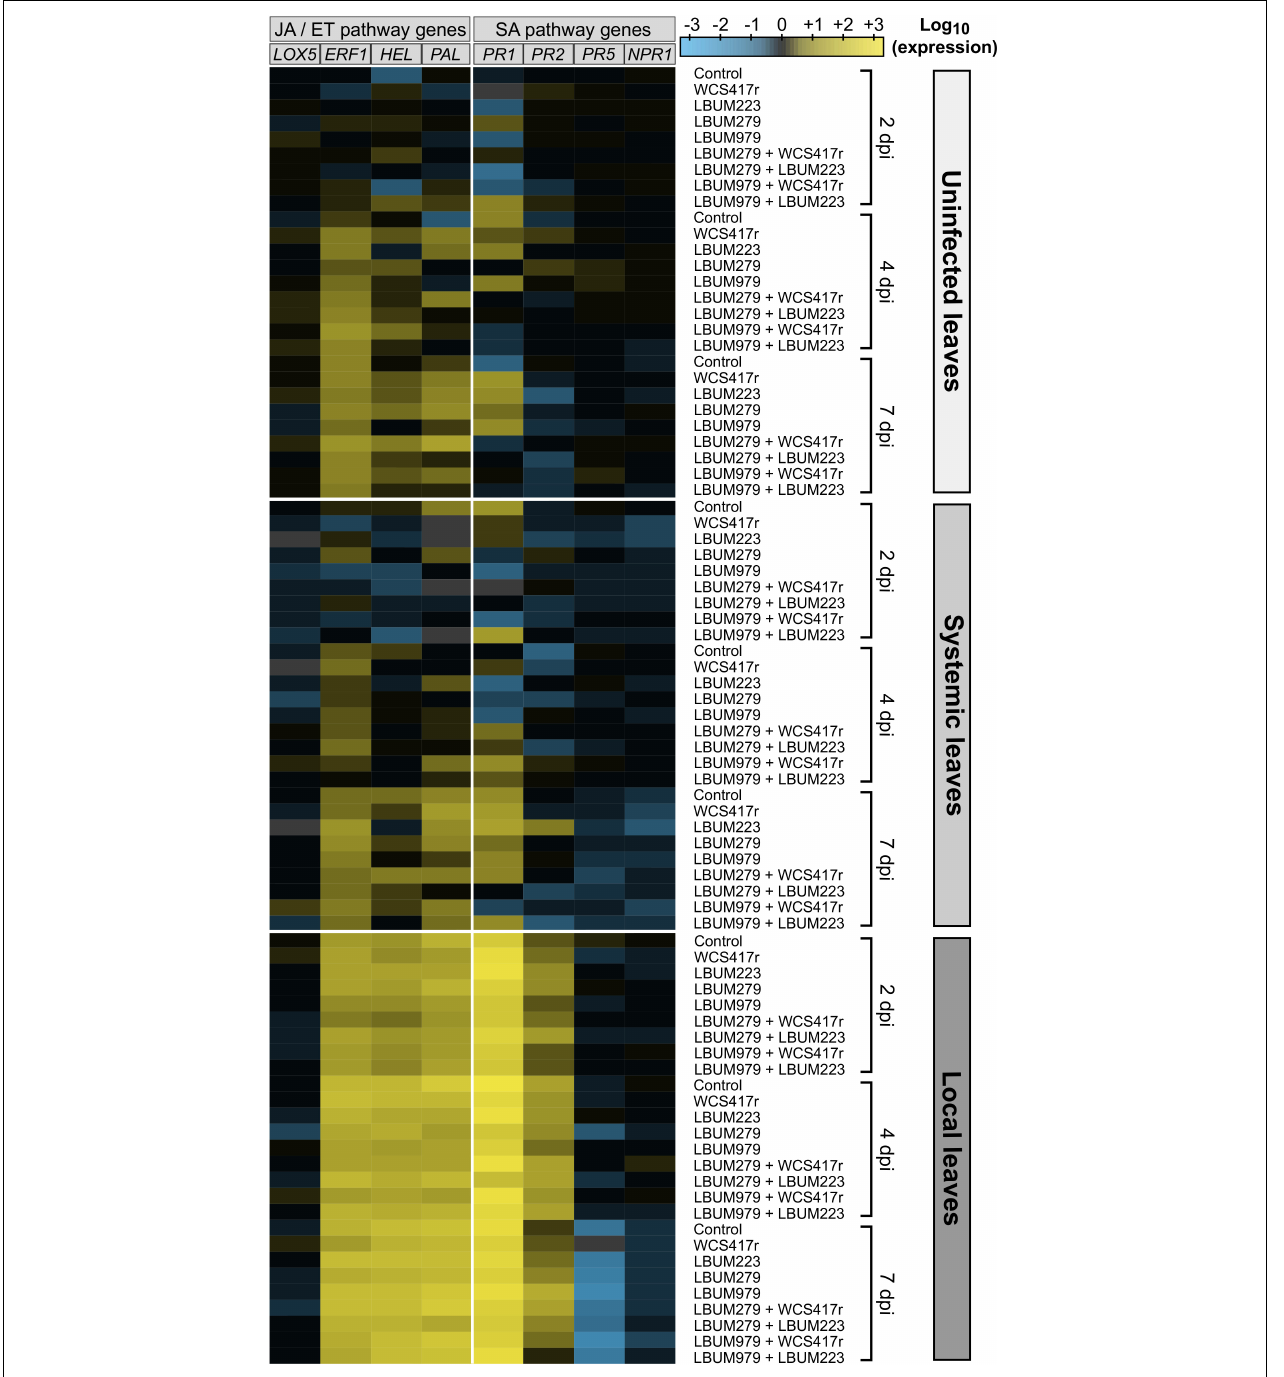
FIGURE 3 | Heatmap showing the expression pattern of putative JA/ET- and SA-mediated genes in cannabis plants primed by Pseudomonas and/or Bacillus strains and infected by B. cinerea . Cannabis seedlings were primed with one of four single-bacteria root treatments, or one of four consortium root treatments, or mock-primed with water (control). After one week, plants were infected with B. cinerea (diseased plants) or left untreated (uninfected plants). After 2, 4, and 7 days (2, 4, and 7 dpi), leaf tissues were sampled from uninfected plants (uninfected leaves) and from diseased plants (systemic leaves remote from infection site and local infected leaves). Total RNA was extracted and the expression level of eight putative defense genes was analyzed by RT-qPCR accounting for primer amplification efficiency. Data were normalized with the reference genes TIP41 and APT1 . Fold changes of expression were scaled per gene relatively to the average expression in uninfected leaves at 2 dpi (set as black on color scale). The heatmap represents the log 10 -transformed mean expression from 4 independent biological replicates and 3 technical replicates; blue indicates lower gene expression than the average expression in uninfected leaves at 2 dpi (downregulation) while yellow indicates higher gene expression (upregulation). Missing values are grayed